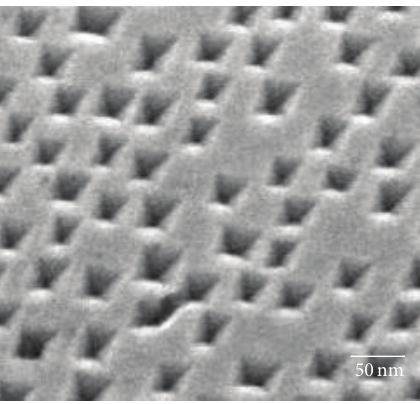
Figure 1: 35 ∘ tilt SEM image of nanopit substrate after KOH etching.